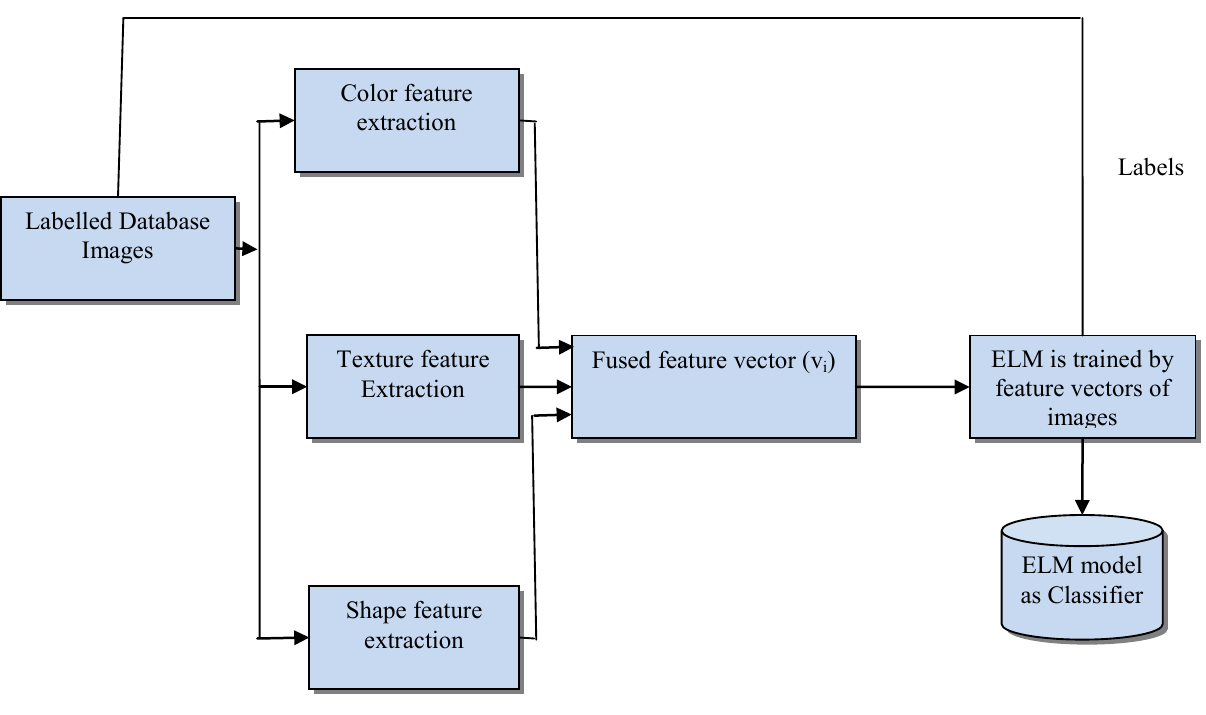
Figure 4 a. Training phase of the proposed system